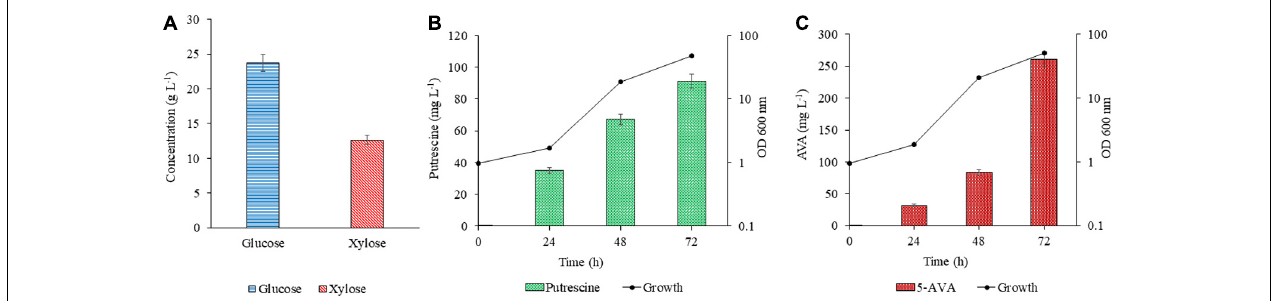
FIGURE 5 | Concentration of glucose and xylose in RSH (A) . Production of putrescine (B) and 5 AVA (C) from RSH. Hydrolysate contained 2.37 g L − 1 glucose + 12.6 g L − 1 xylose. The downward diagonal column represents the production and the line graph with marker shows the absorbance at OD 600 nm. Measurements are given as means from triplicates of independent cultivations with standard